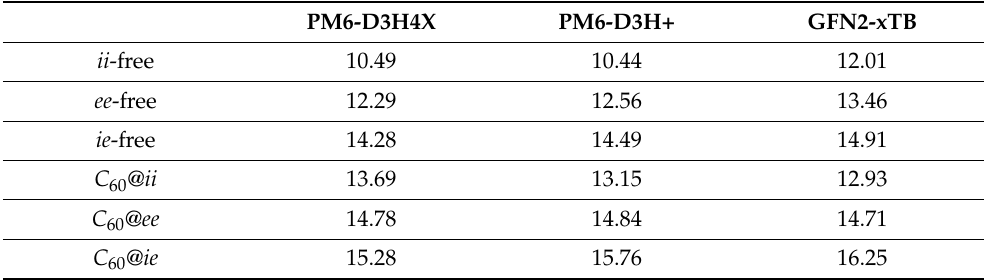
Table 1. R P distances (in Å) or the several conformers of the corannulene pincer according to the four methods used in this